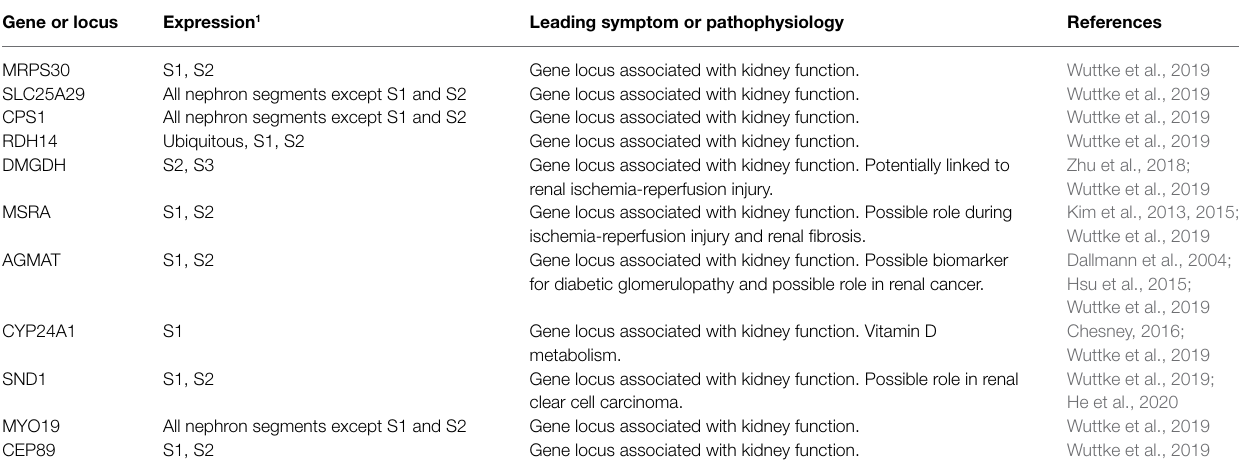
TABLE 2 | Examples of gene loci of mitochondrial proteins associated with kidney